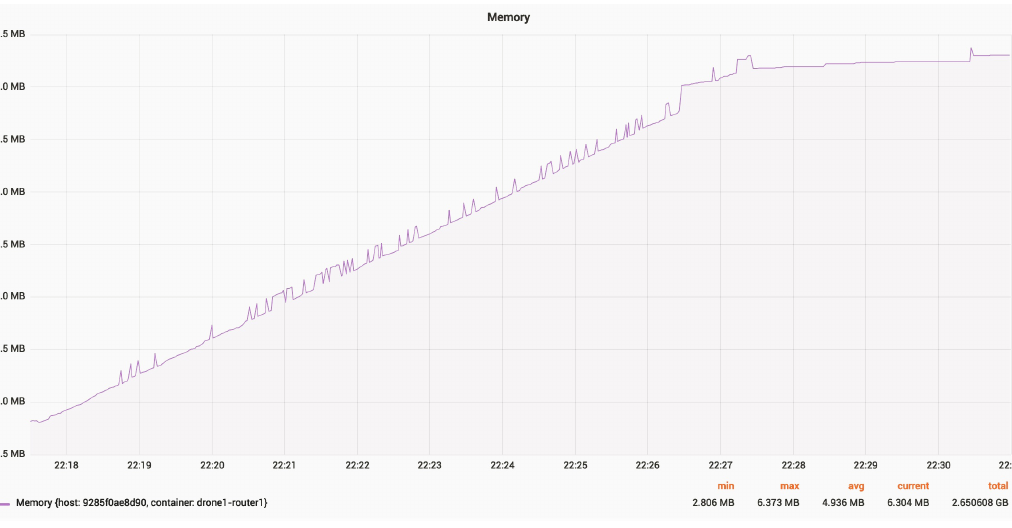
Figure 25. RAM usage for a